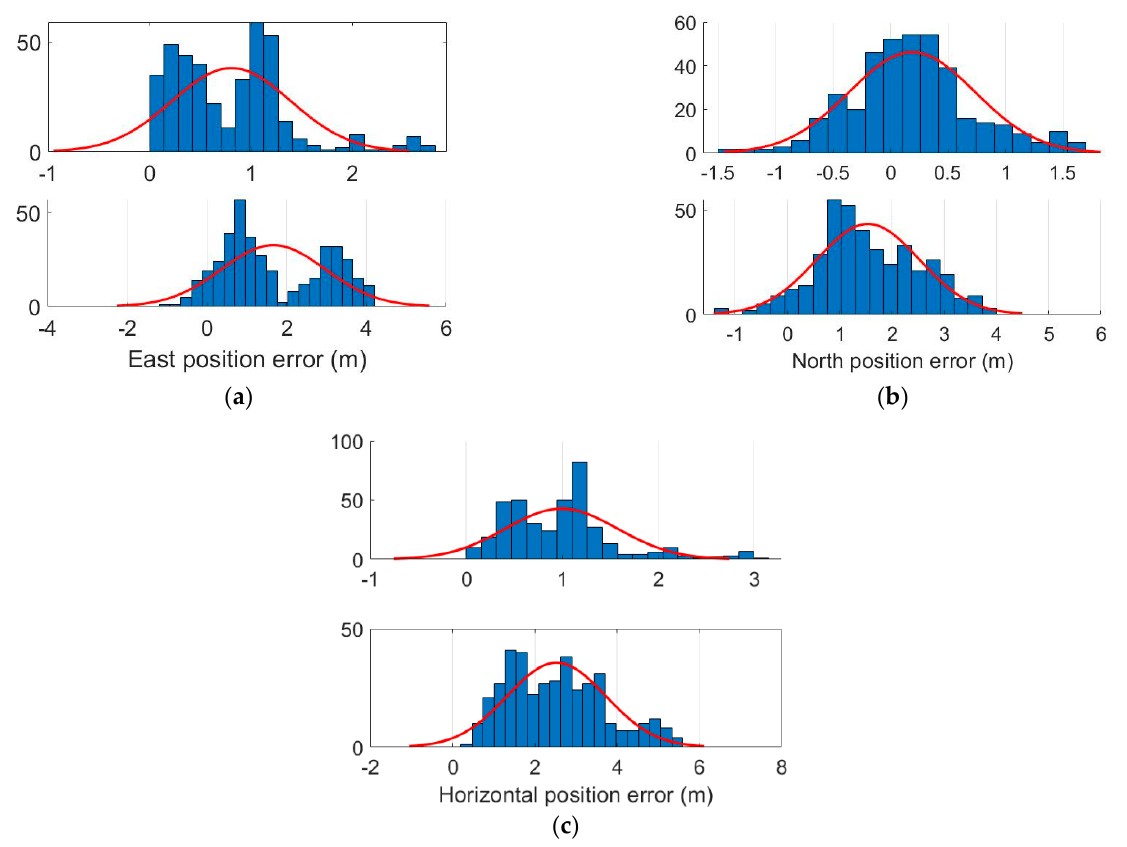
Figure 7. Position errors distribution. ( a ) East-position errors distribution. ( b ) North-position errors distribution. ( c ) Horizontal-position errors distribution.